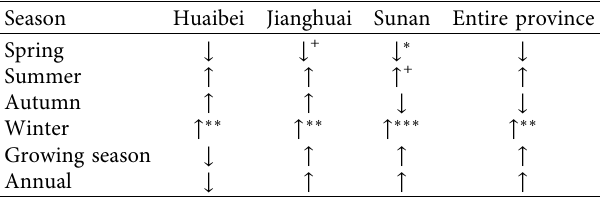
↓ ↑ ↑ ↑ Note: ∗∗∗ , ∗∗ , ∗ , and + indicate significance levels of 0.001, 0.01, 0.05, and 0.1,